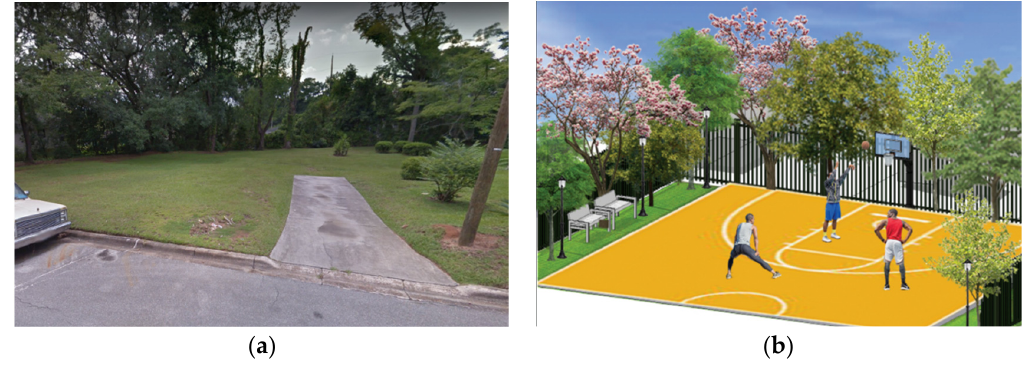
Figure 7. Urban infill development recreation: before (a); and after (b).